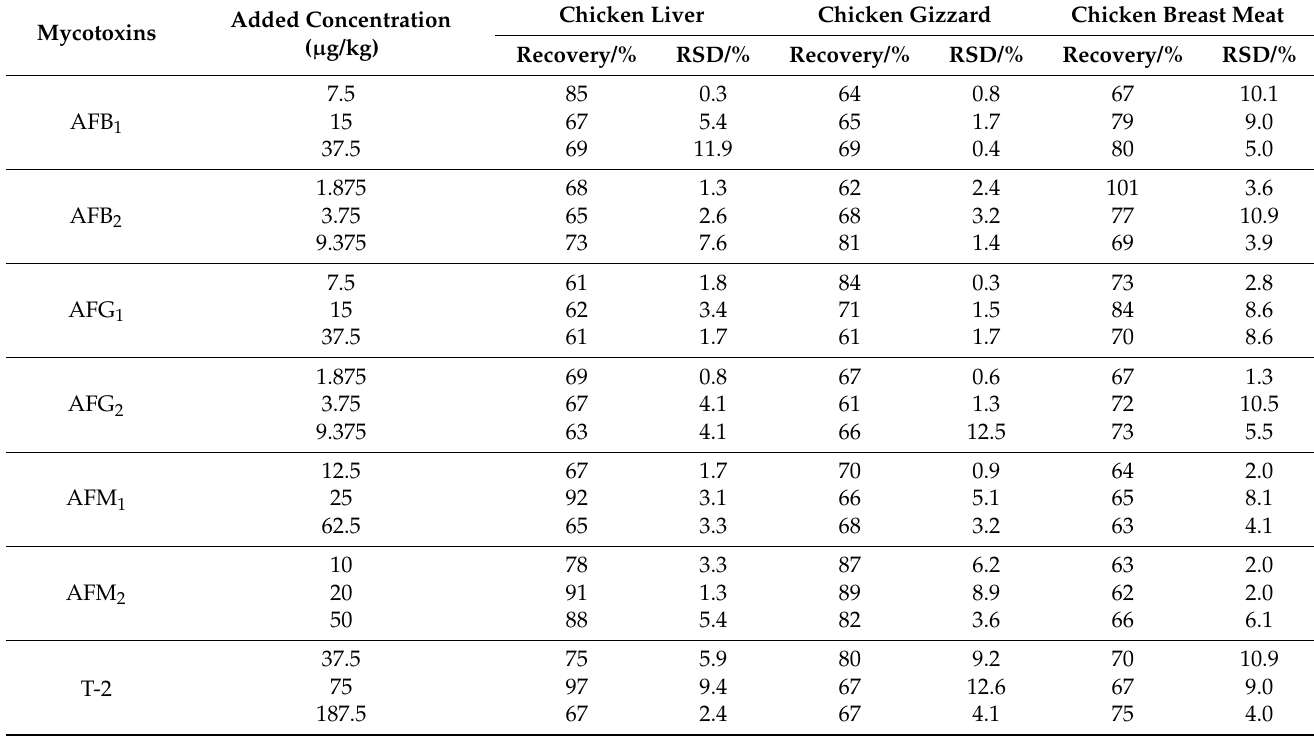
Table 4. Recoveries of 23 mycotoxins at 3 levels (n =